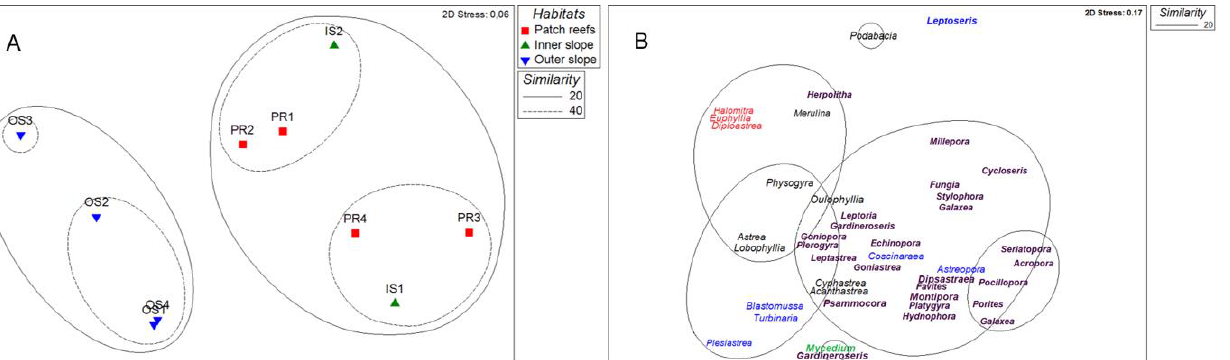
Figure 6. Mean abundance of colonies of the eight major coral genera at the 10 stations located on the three major habitats (PR: patch reefs, IS: inner slope, and OS: outer slope). Error bars represent standard error.